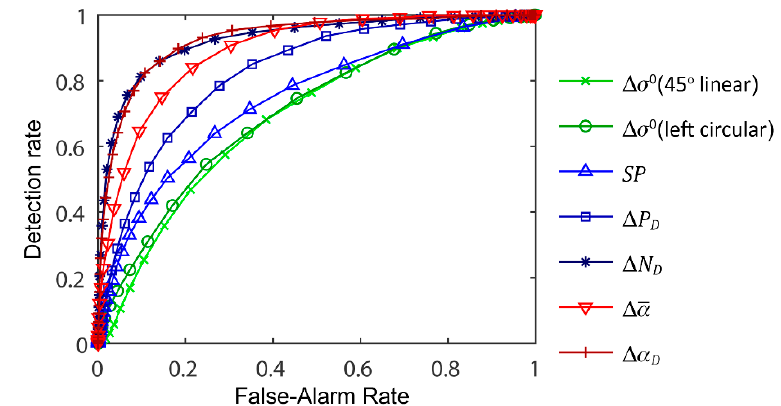
Figure 8. The receiver operating characteristic curves for selected polarimetric change indicators.